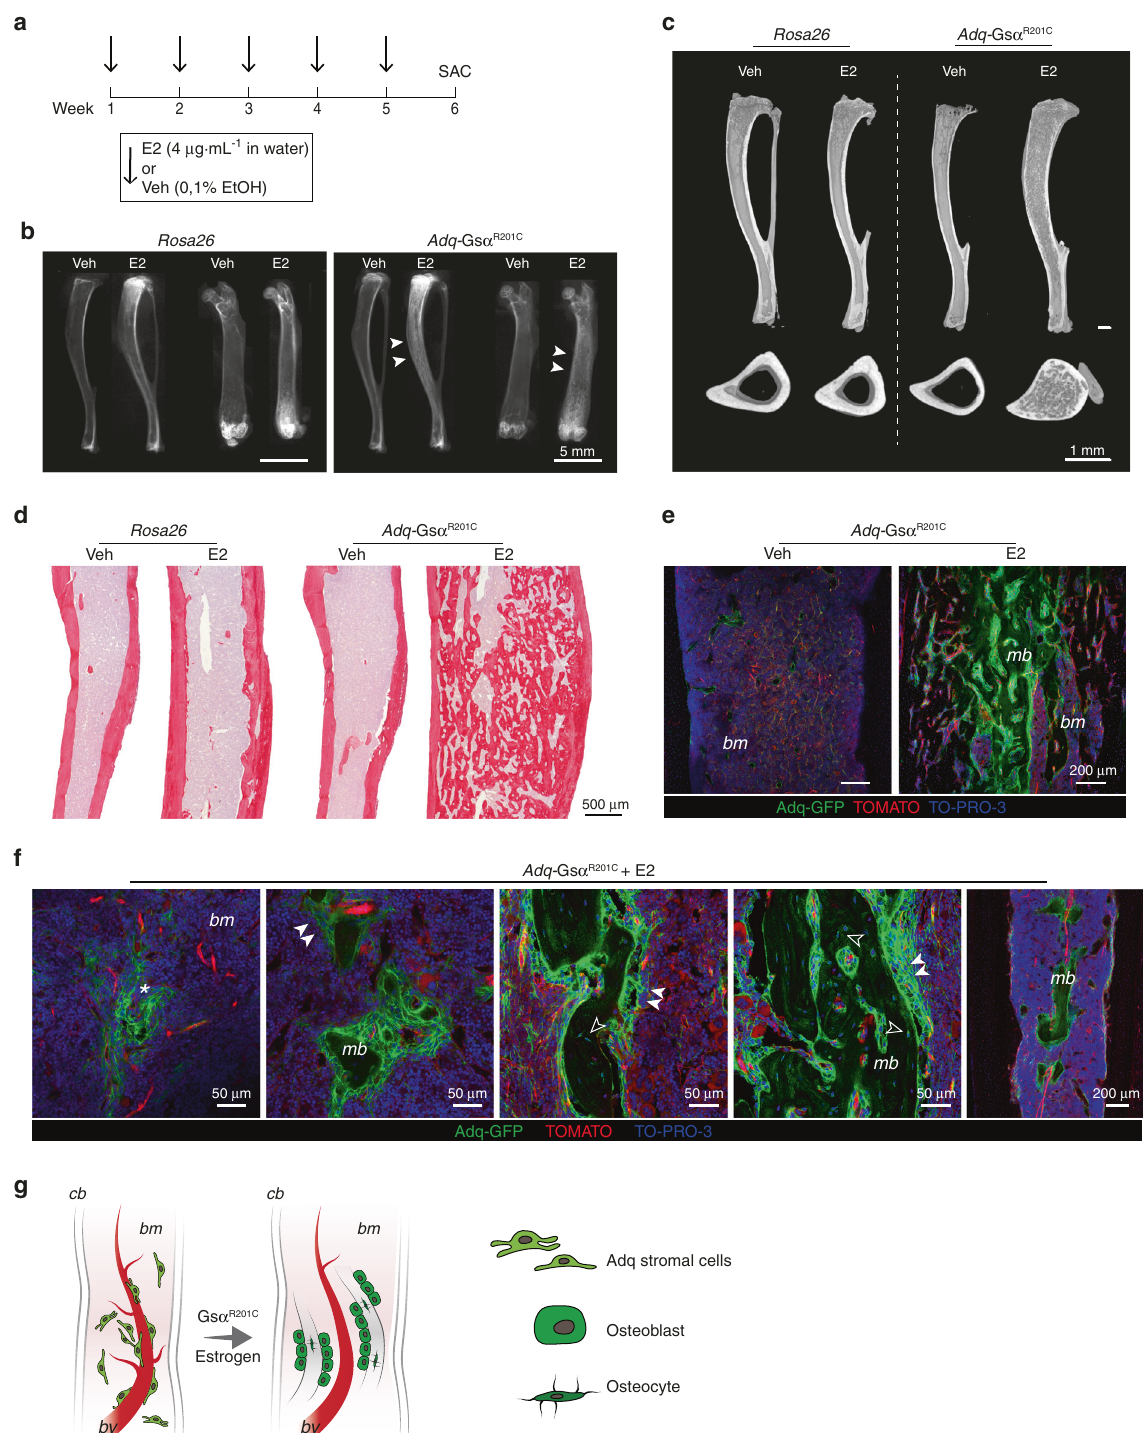
Fig. 6 Diaphyseal intramedullary bone formation is reproduced in Adq-Gs α R201C male mice by 17 β -estradiol (E2) treatment. a Experimental scheme of E2 treatment started at 5 months of age. b Radiographs of dissected tibiae and femora at the end of E2 treatment. Arrowheads indicate the increased density in the diaphyseal region of E2-treated bone segments from Adq-Gs α R201C mice. c Representative longitudinal and transverse micro-CT images of Veh- and E2-treated mice, showing the diaphyseal intramedullary bone in E2-treated Adq-Gs α R201C male mice. Transversal images were taken 2 mm above the tibia- fi bular junction. d Sirius red stained sections of the tibial midshafts showing intramedullary bone in Adq-Gs α R201C male mice after 6 weeks of E2 treatment. e Representative confocal images showing GFP-labeled intramedullary bone in E2-treated Adq-Gs α R201C male mice. No bone is observed in Veh-treated mice. f Cluster of perivascular GFP-labeled stromal cells ( asterisk ) preceding the appearance of bone with GFP-labeled osteoblasts ( arrowhead ) and osteocytes ( hollow arrowhead ) in the marrow cavity of E2-treated Adq-Gs α R201C mice. g Schematic representation of GFP-labeled medullary bone formation by Adq-Gs α R201C marrow perivascular/stromal cells. mb Medullary bone, bm Bone marrow, cb Cortical bone, bv Blood